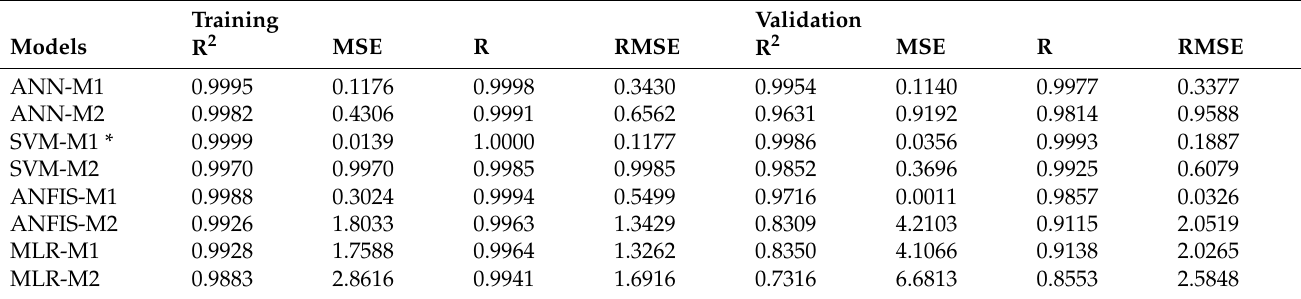
Table 2. Performance evaluation of TDSt for ANN, SVM, ANFIS, and MLR.